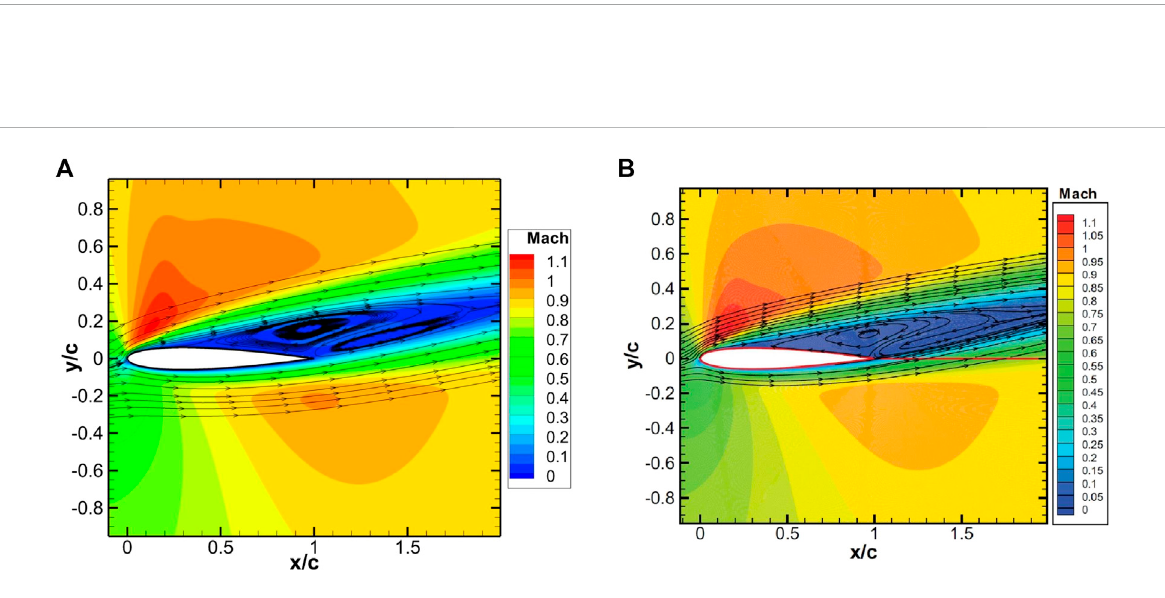
to the calculated analytical value (listed in Table 2). The percentage error of the computed value is determined to be about 0.57%. The contour plot of the Mach number is shown in Figure 14, and a comparison is also made with the CUS-IBM (Kumar et al., 2020). The contour plots are in good agreement. It can be seen from the contours that there is a detached bow shock formed in front of the cylinder, and the solutions on the two different IBM solvers compare